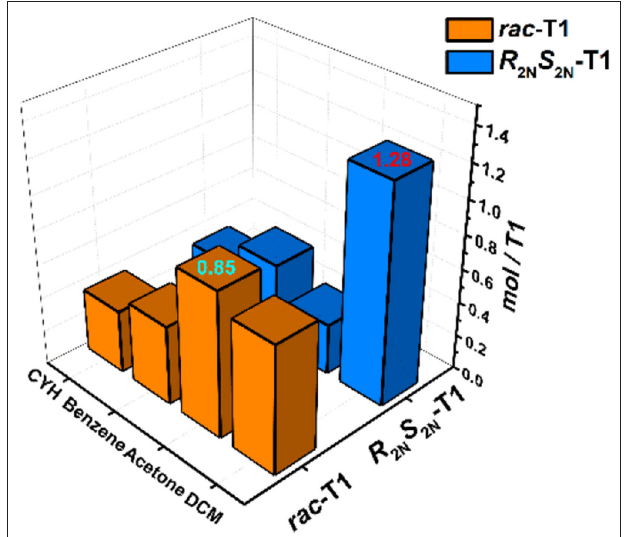
FIGURE 5 | Gas adsorption experiments in rac -T1 or R 2 N S 2 N -T1 with dichloromethane (DCM), acetone, cyclohexane, benzene, respectively.